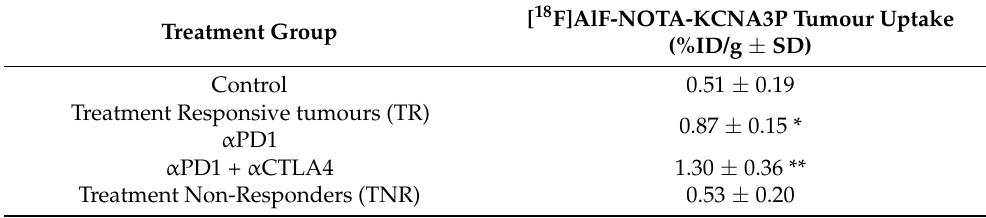
Table 1. Table Shows CT26 tumour retention of [ 18 F]AlF-NOTA-KCNA3P in vivo after ICI treatment evaluated by PET/CT. Data are shown as the mean %ID/g ± S.D. of control groups, treatment responsive tumours (TR) across treatment cohorts and treatment non-responders (TNR) ( n = 10 mice/ group; * p < 0.05; ** p < 0.01, comparing TR to TNR).